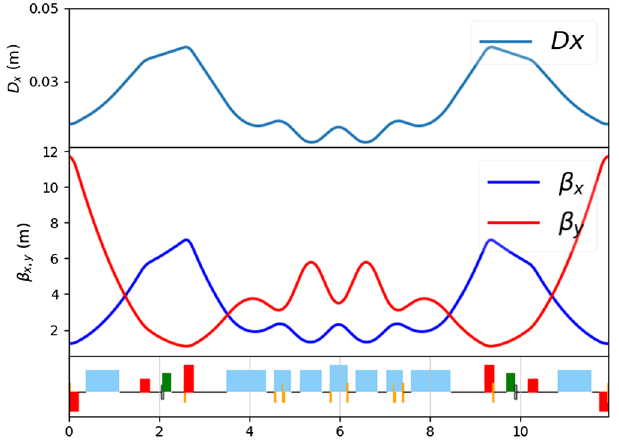
FIG. 5. Straight section with the triplet optics including the skew FODO phase space exchange section. The optical functions are plotted for the quadrupoles set in the normal (not skew)